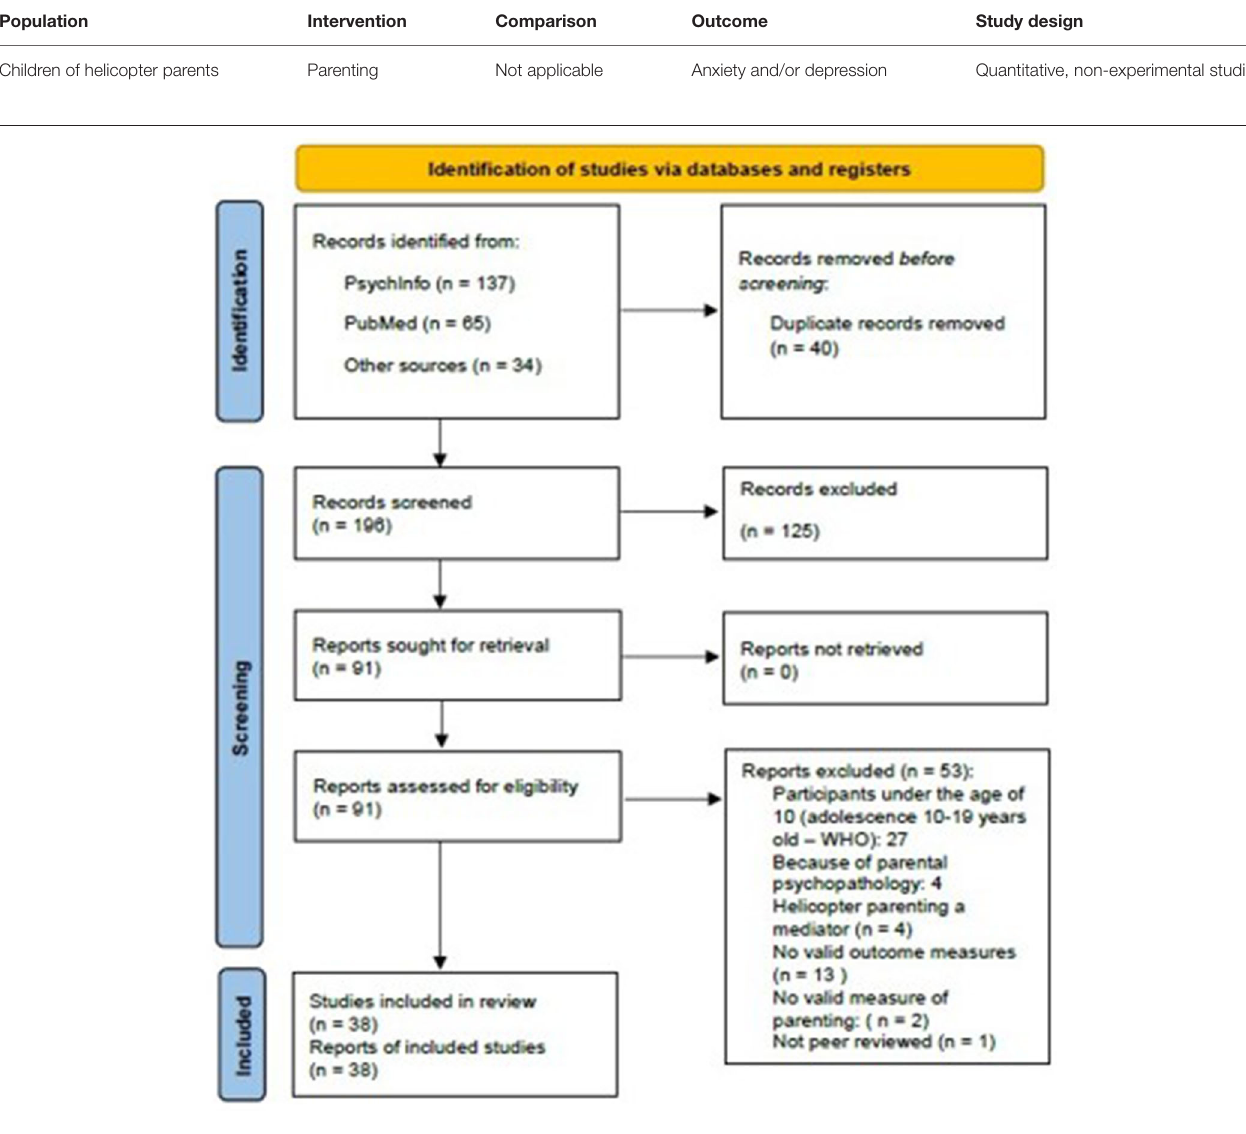
FIGURE 1 | Prisma flow